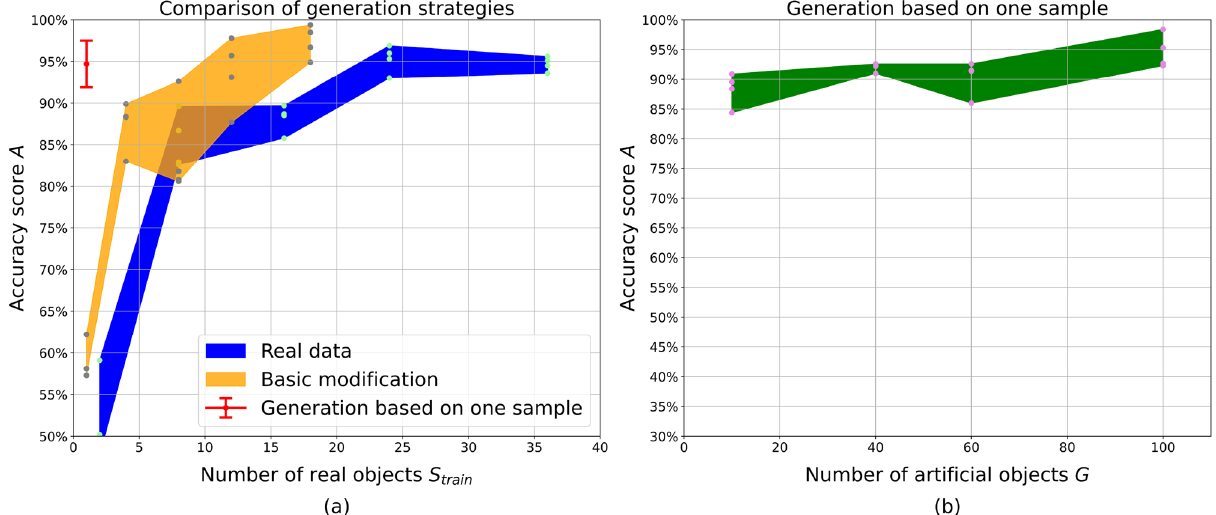
Figure 6. Dependency of avocado classification accuracy A on the amount of data provided for training. ( a ) Comparison between training on real data and generated images with a different number of real samples S train . ( b ) Training on the artificial images generated based on one experimentally scanned